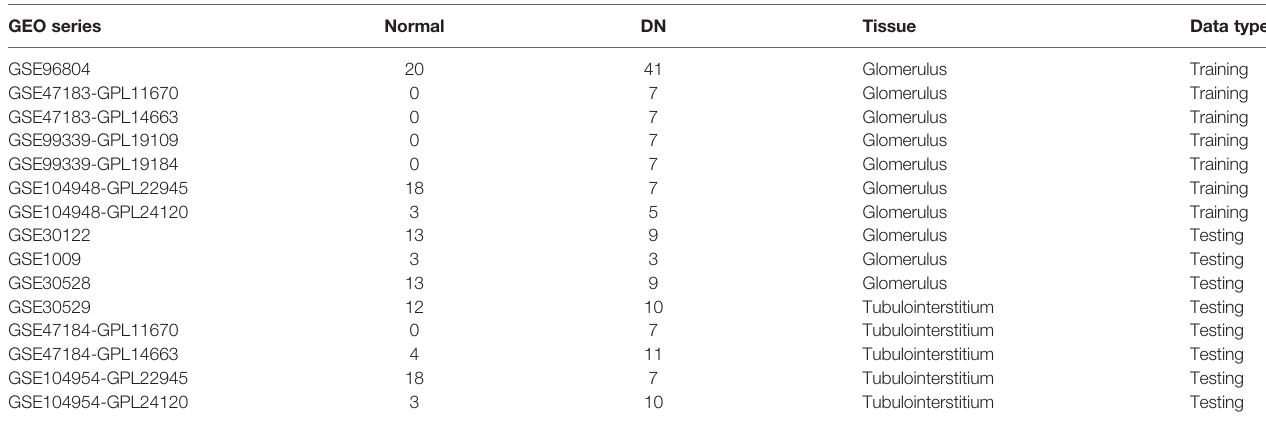
TABLE 1 | The essential information of included microarray datasets in this